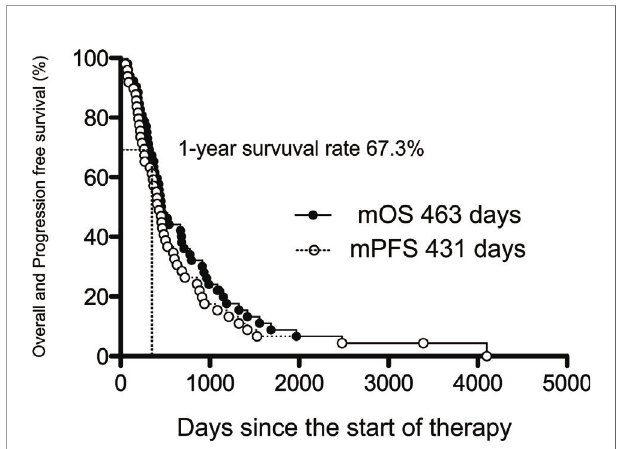
FIGURE 2 | The median overall and progression-free survival of AI+RT in biliary tract cancer (BTC). Kaplan-Meier estimates of the mOS and mPFS. The mOS, mPFS, and 1-year survival rate were 463 and 431 days (15.4 and 14.3 months) and 67.3%, respectively.